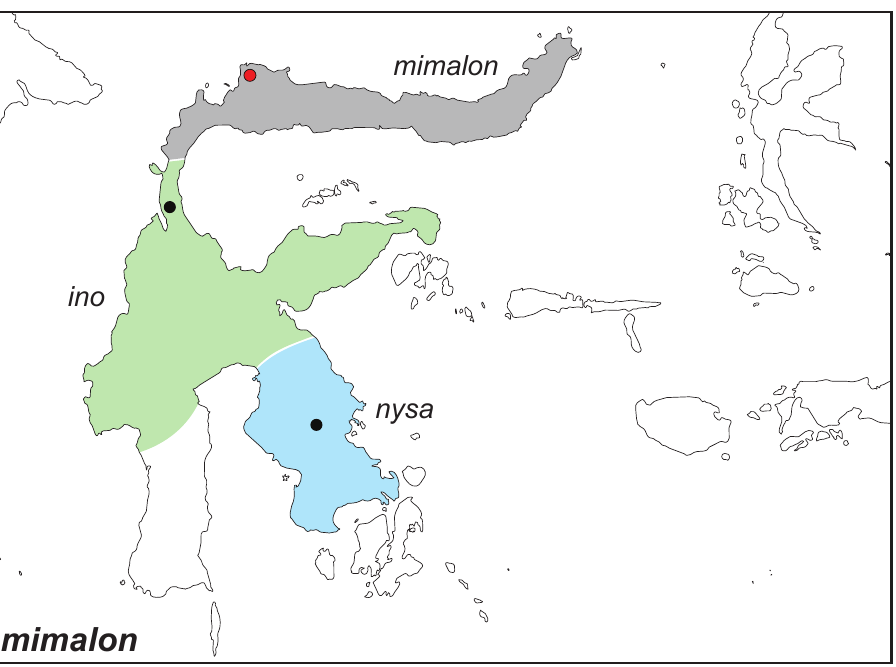
Figure 70. Distribution map of Elymnias mimalon